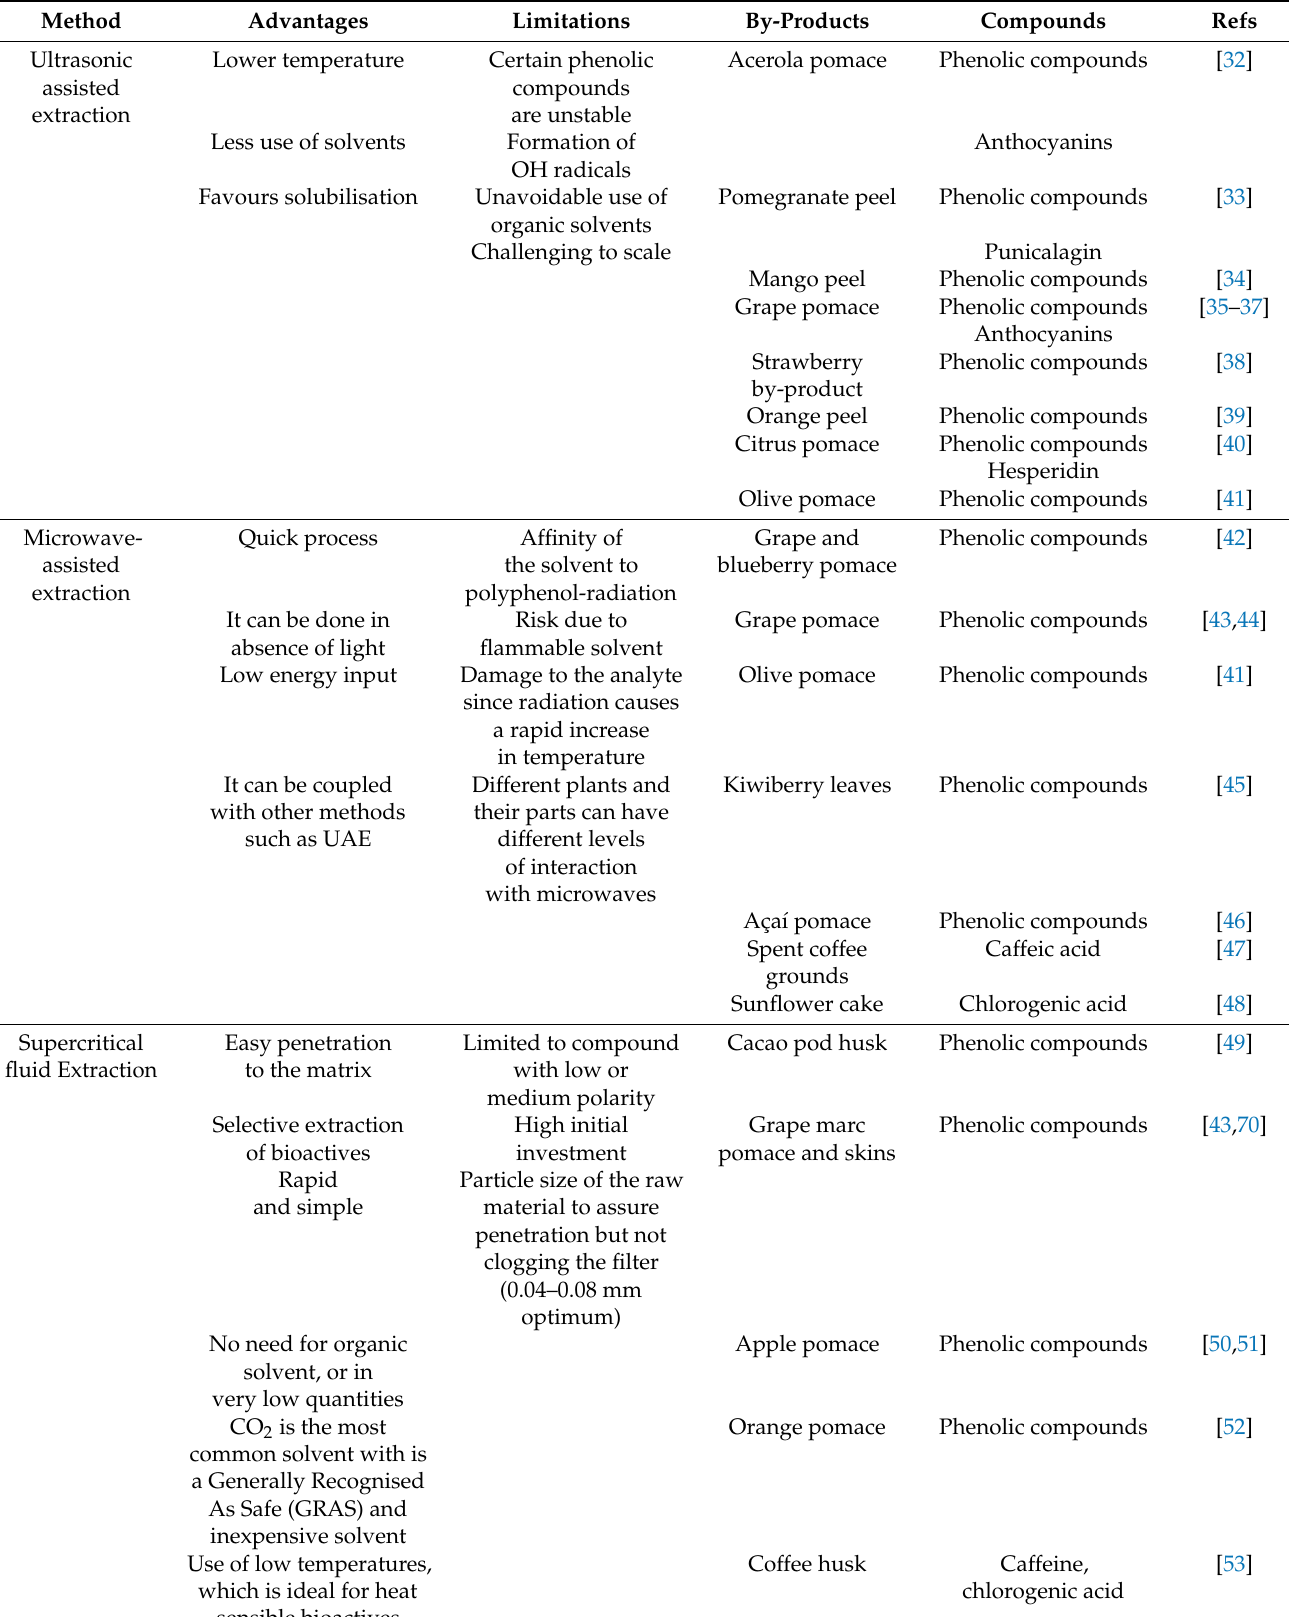
Table 1. Green methods for polyphenol extraction from agri-food by-products and